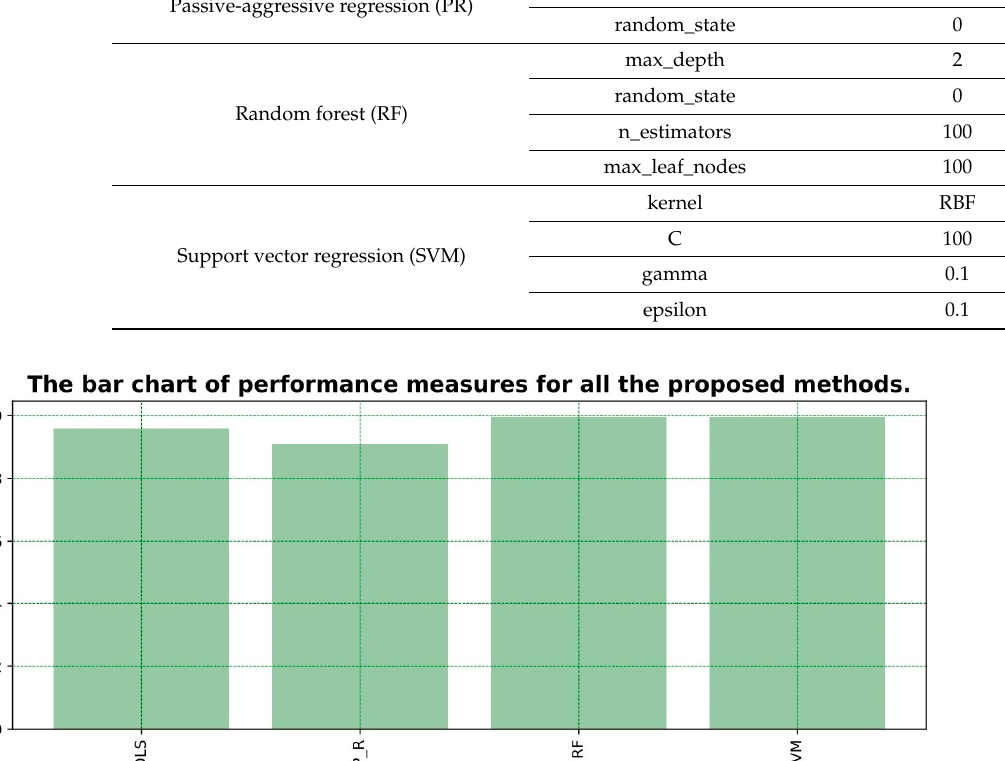
Figure 5. Boxplot of the performance measures for the proposed ML techniques. 5.1. Comparative Simulations To further analyze the precision and effectiveness of the proposed techniques, simu ‐ lation is carried out to select the efficiency of the proposed speed controller. Comparative simulations are performed among the proposed FOSMC based on ML models, and also with conventional SMC to verify the effectiveness. The reference speed is set to 1000 rpm as a step signal and starts without a load. The speed tracking control responses of the FOSMC based on ML models and the SMC are shown in Figure 6. As can be seen from this figure that the speed of the PMSM system under the proposed FOSMC based on ML models has a better transient response profile than the conventional SMC as it performs with faster stability and without overshoot. When comparing the linear ML (OLS, PR) model with non ‐ linear ML, as illustrated in Figure 6a, the speed controllers using OLS ‐ FOSMC and PR ‐ FOSMC experience less chat ‐ tering and are more stable compared to RF ‐ FOSMC and SVM ‐ FOSMC. However, all the proposed ML models indicate that the control effects are excellent, with less error in the steady ‐ state phase. On the other hand, the speed performance of the SMC is poor, which needs more time to regulate the reference speed and undergoes a considerable tracking error with large chattering while tracking the speed reference, as depicted in Figure 6b.